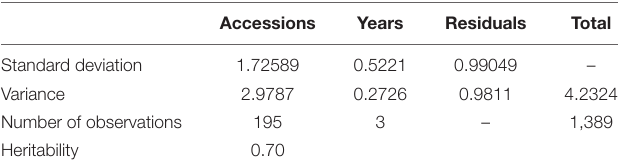
TABLE 1 | Variance components, standard deviations of the variance components, and broad-sense heritability of peach gummosis disease evaluated over 2 years in 195 peach